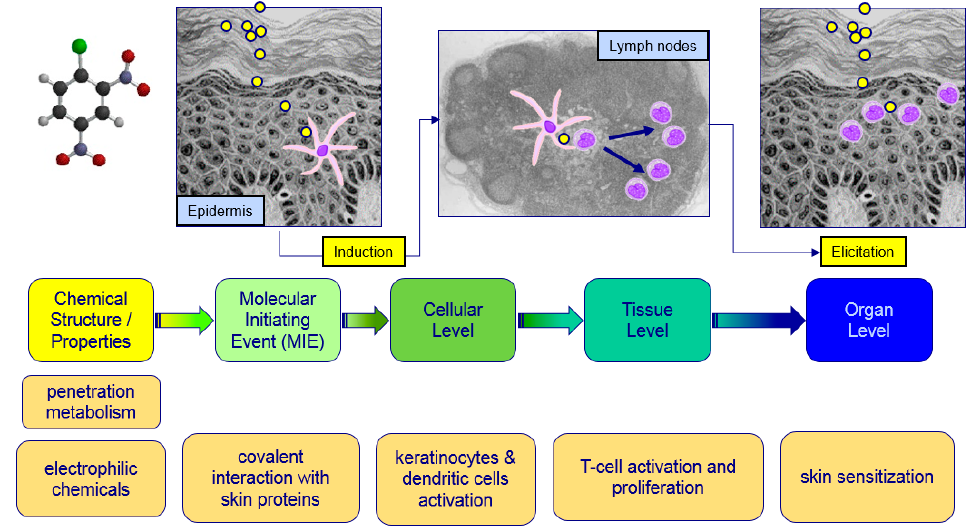
Figure 1. Modified schema of the Adverse Outcome Pathway for skin sensitization developed by the OECD [23] and updated by the related AOP WIKI [25].